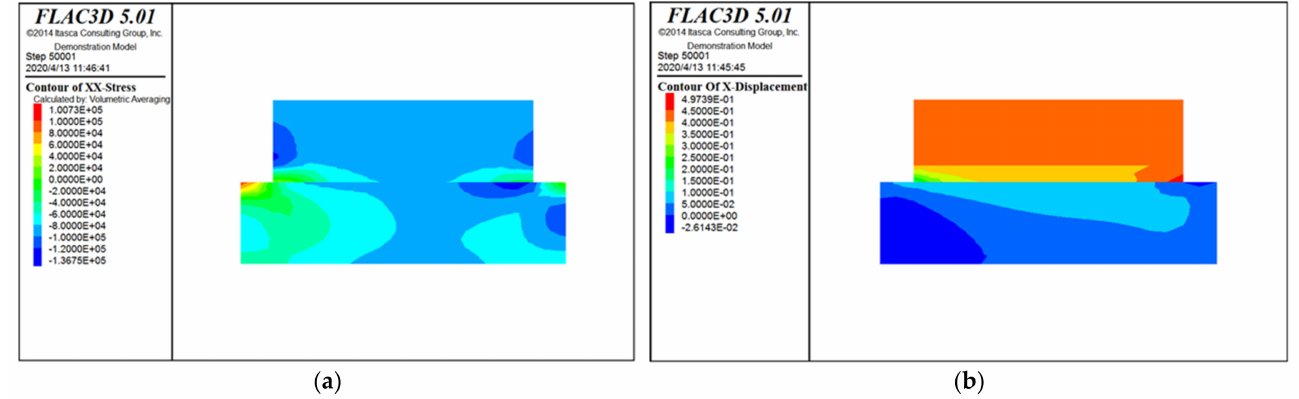
Figure 10. X -direction stress and displacement cloud diagram. ( a ) Stress cloud diagram; and ( b ) displacement cloud diagram.